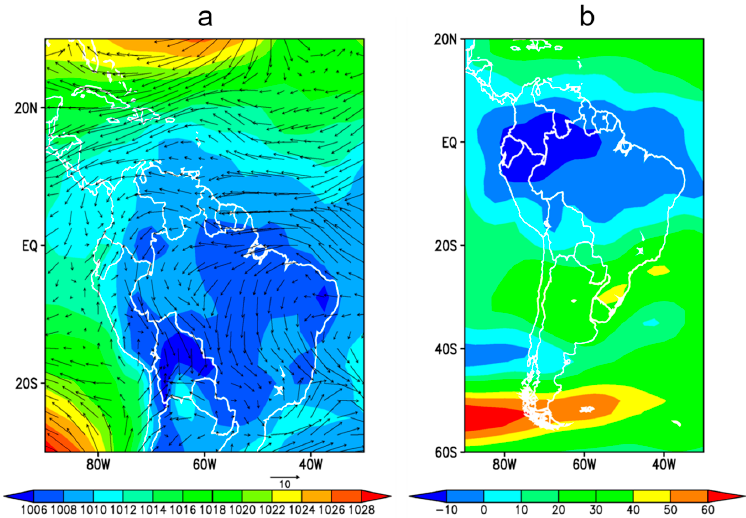
Figure 7. ( a ) Reduced sea level pressure (shaded, in millibars) and horizontal wind fields (arrows) at the 850hPa pressure level. ( b ) Zonal wind field (m/s) at 200 hPa pressure level. The date corresponds to the onset of the SSL on 30 November 1998 at 18 UTC. Data is from the The National Centers for Environmental Prediction (NCEP) Reanalysis data [44].